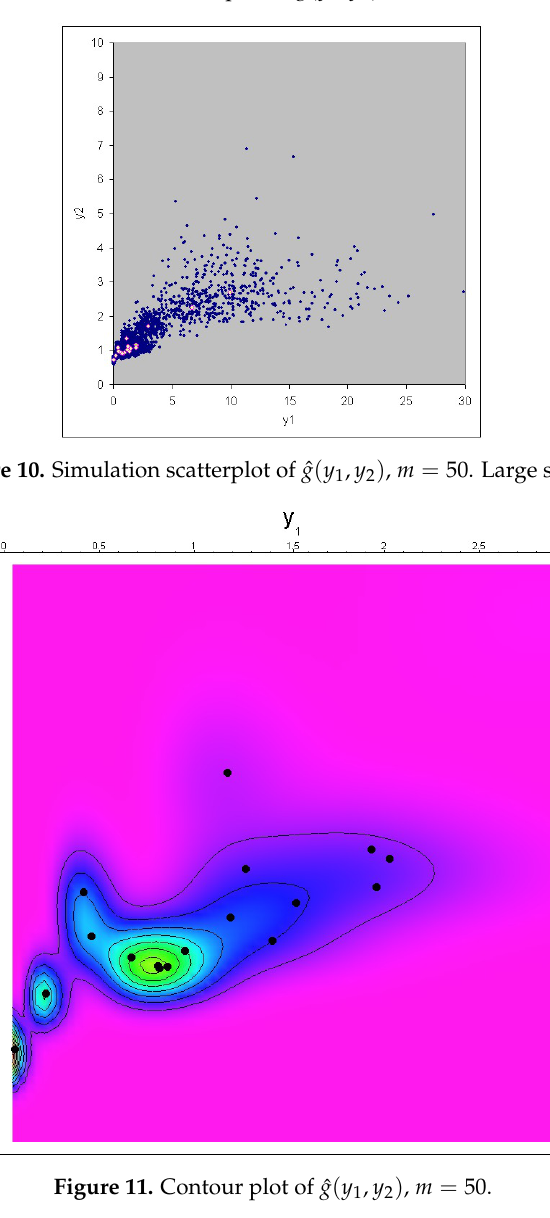
Figure 9. Simulation scatterplot of ˆ g ( y 1 , y 2 ) , m = 50. Small scale.